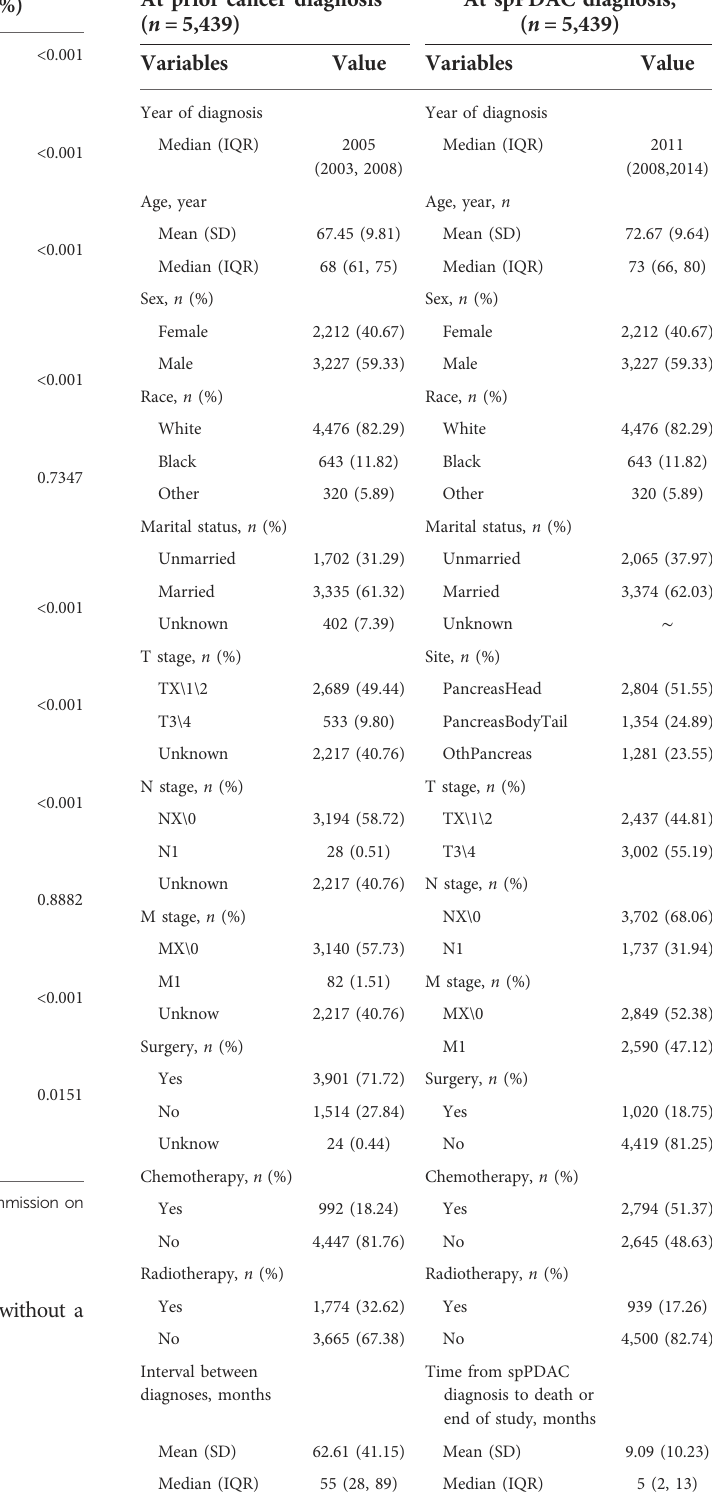
TABLE 1 Demographic characteristics of patients. TABLE 2 Overview of demographic and clinical factors in spPDAC